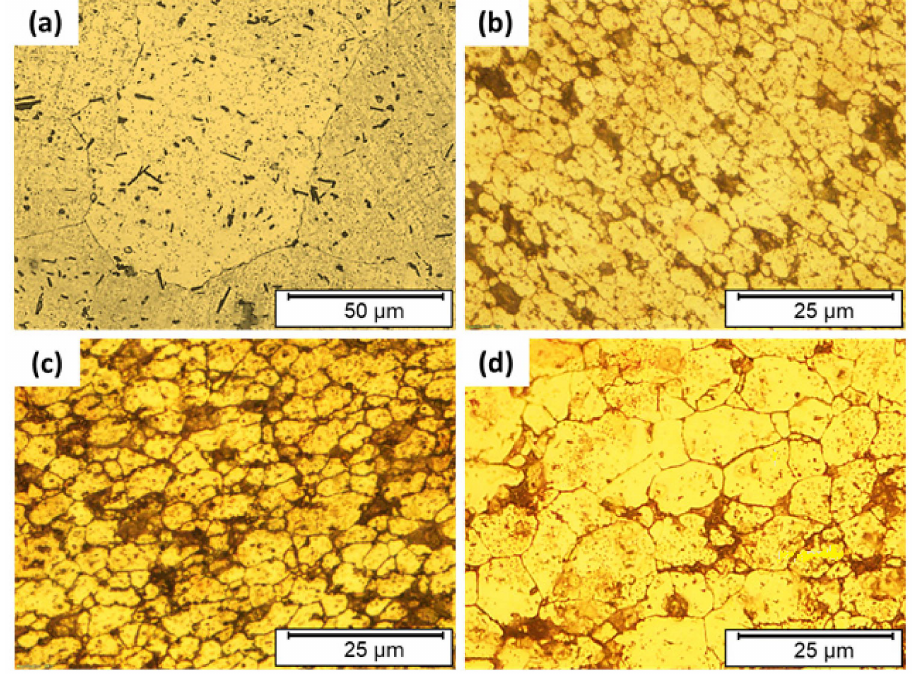
Figure 6. Optical microstructures of the as-received AA2011-T6 ( a ), and AMPs produced t at a rotation